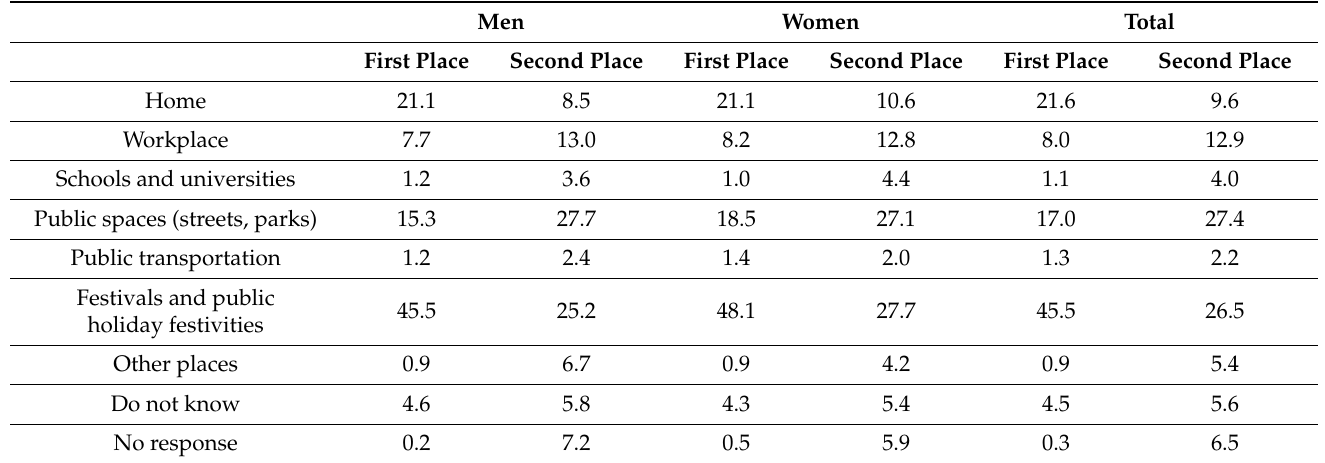
Table 2. From your perspective, where do sexual assaults occur most frequently?